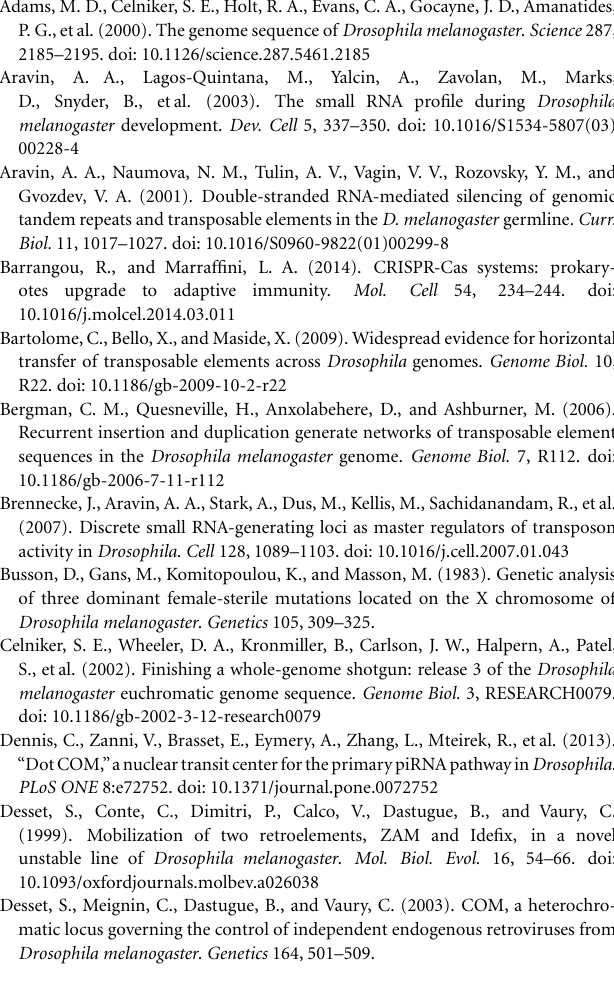
The best genetic background for a TE family to transpose is to enter a virgin genome in which no homologous sequence